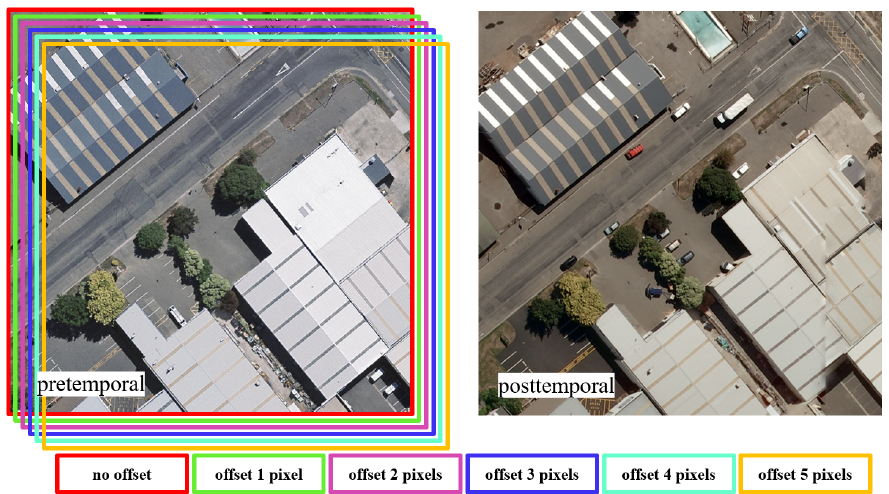
Figure 13. The way bitemporal images are shifted.